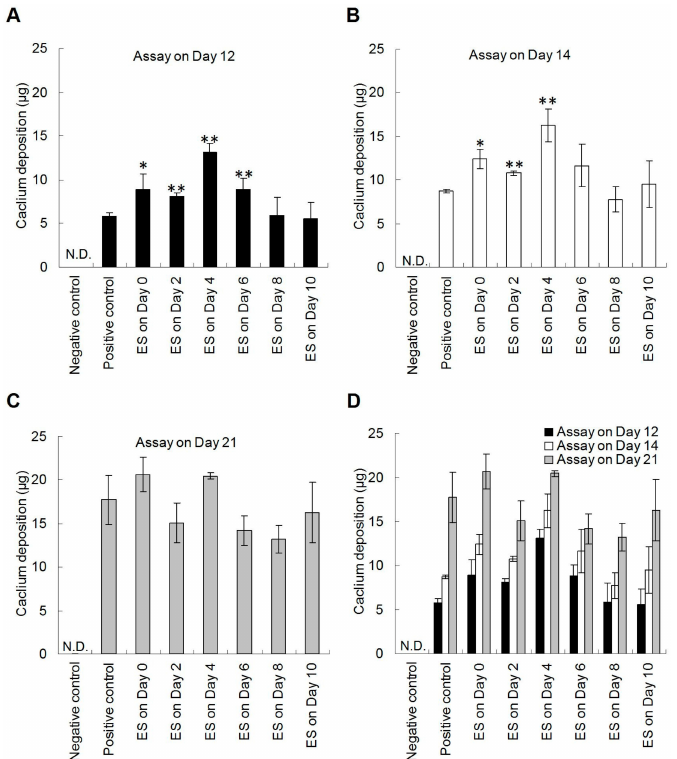
Figure 5. The calcium deposition of hDPSCs under DCEF treatment on di ff erent days during osteo-di ff erentiation. To determine the temporal e ff ects of ES on mineralization, hDPSCs seeded on PPy films were treated with DCEF (0.33 V / cm) for 4 h on di ff erent days after the induction with osteogenic medium. The calcium deposition of cells was evaluated using calcium-(ocresolphthalein complexone) (Ca-OCPC) complex method on ( A ) day 12, ( B ) day 14, and ( C ) day 21 after osteo-induction. ( D ) The overall results were grouped to better understand the e ffi cacy of ES. The negative and positive control groups were hDPSCs cultured on PPy films using normal or osteogenic media, respectively. These two control groups were not treated by DCEF. ( n = 3; *: p < 0.05, **: p < 0.01 compared with the